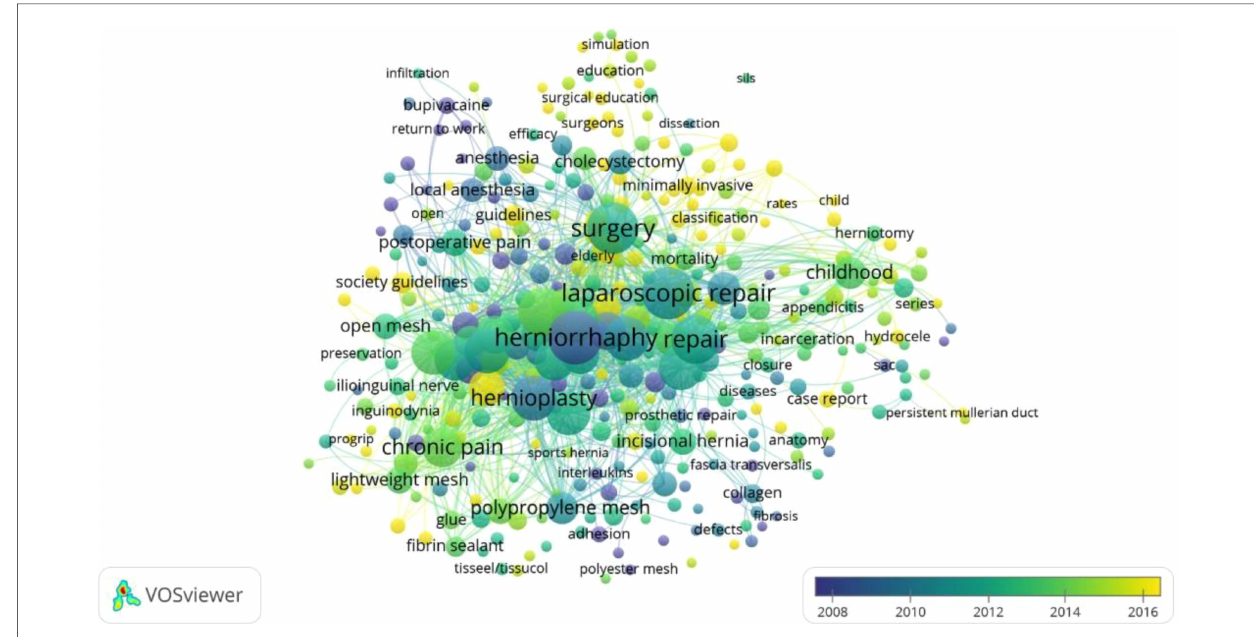
FIGURE 3 Bibliographic coupling network of terms most used in the web of science database.